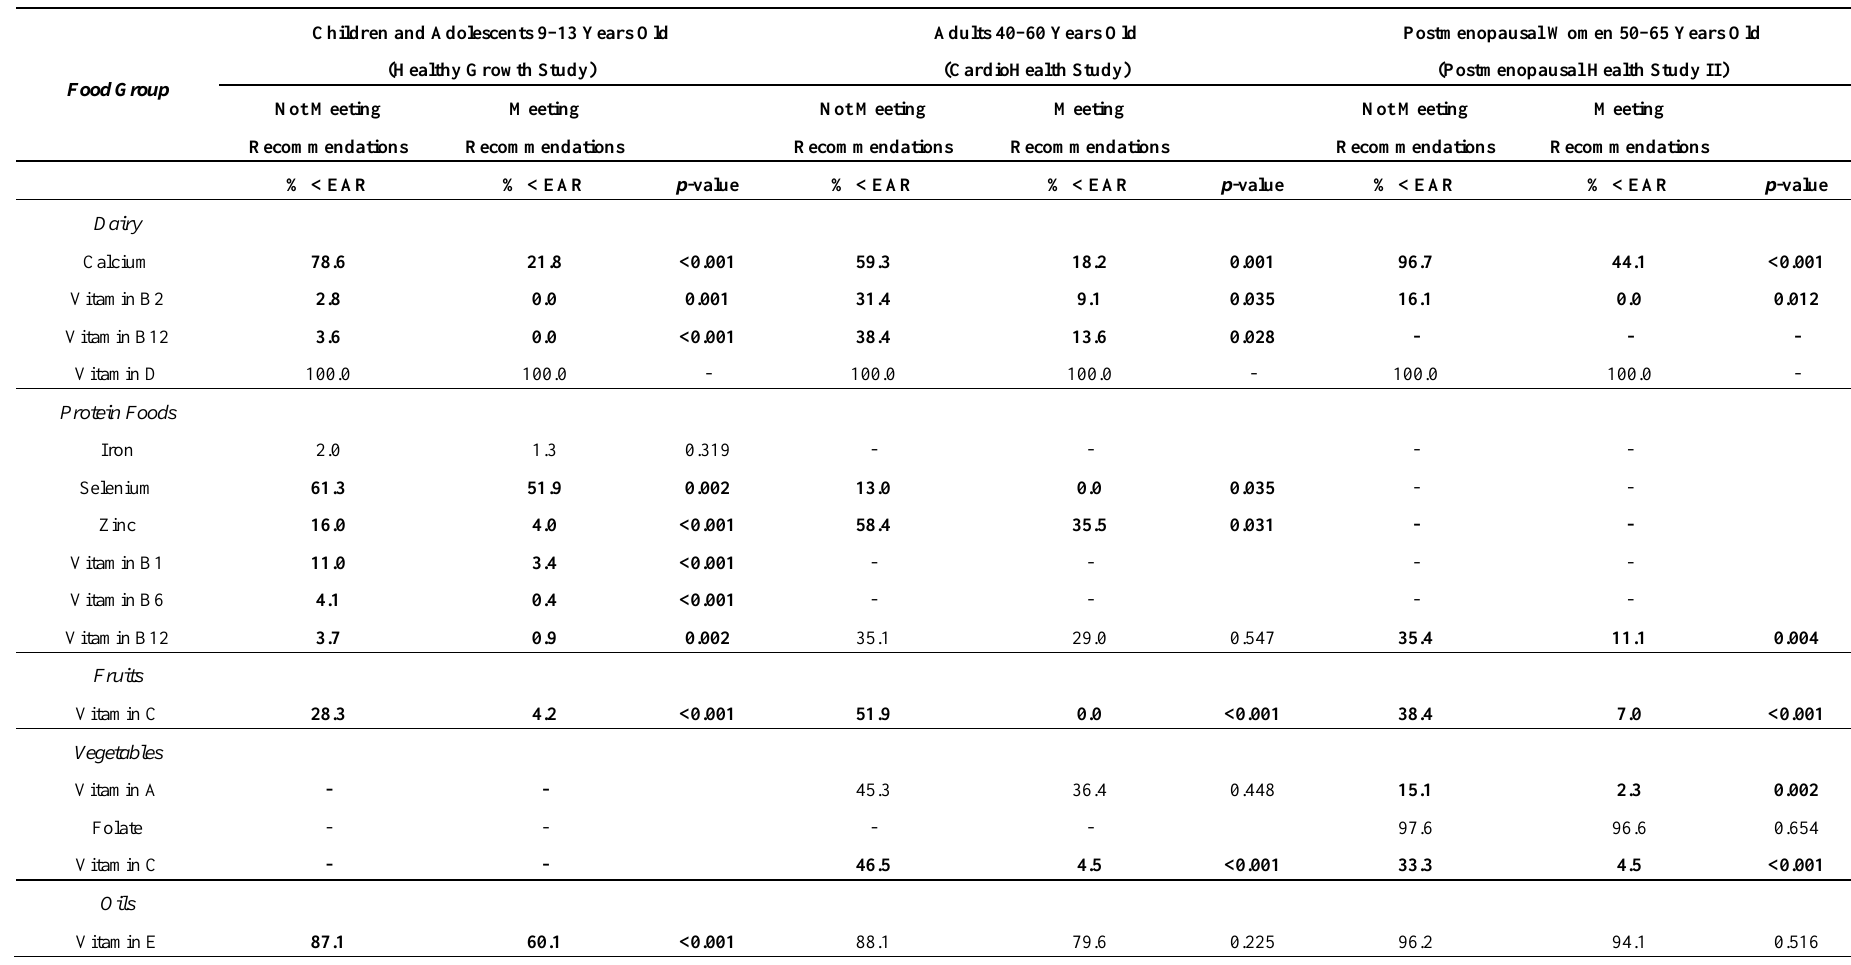
Table 4. Percentages of children, middle-aged adults and postmenopausal women with intakes below EAR for certain micronutrients in those subjects meeting and those not meeting the recommended † consumption of the food group that contributes the most to the intake of the specific